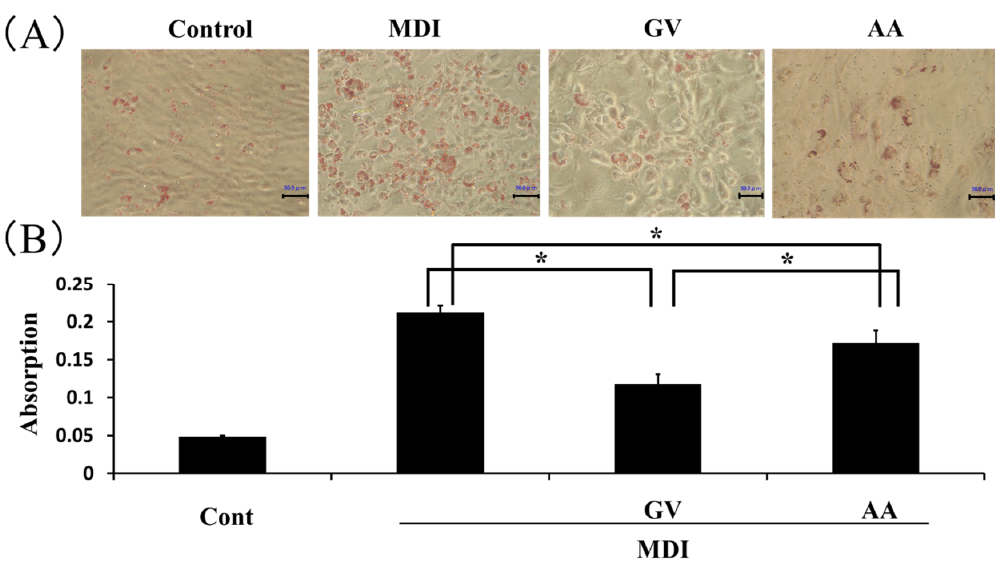
Figure 2. Effect of ginkgo vinegar and acetic acid on lipid accumulation in 3T3-L1 cells. Confluent 3T3-L1 cells were induced to differentiate into adipocytes with differentiation medium (MDI), in the presence of 0.4% ginkgo vinegar (GV) or 0.02% acetic acid (AA) for 5 days. ( A ) Lipid droplets in the cells were stained with Oil-Red O. Scale bar indicates 50 μm. ( B ) The intracellular dye was extracted with 100% isopropanol, and absorbance was measured at 492 nm. Data represent the mean ± SD ( n = 3). * p < 0.05.